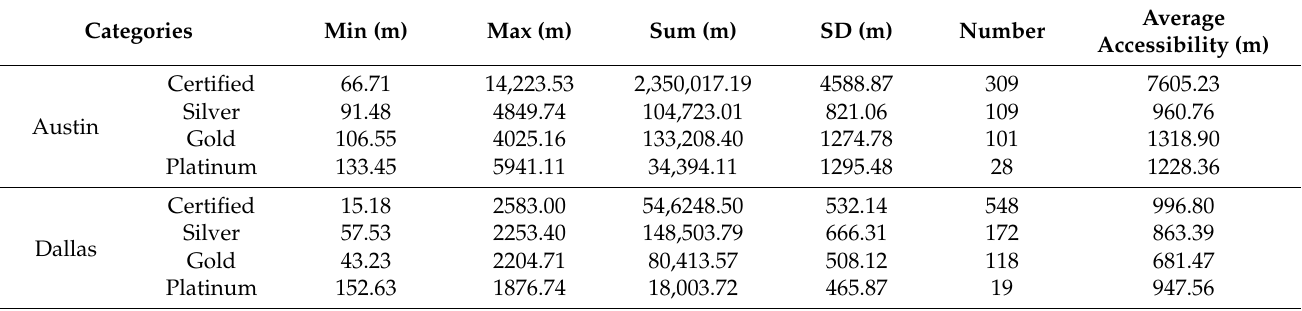
Table 5. Accessibility of green spaces for different green building certification